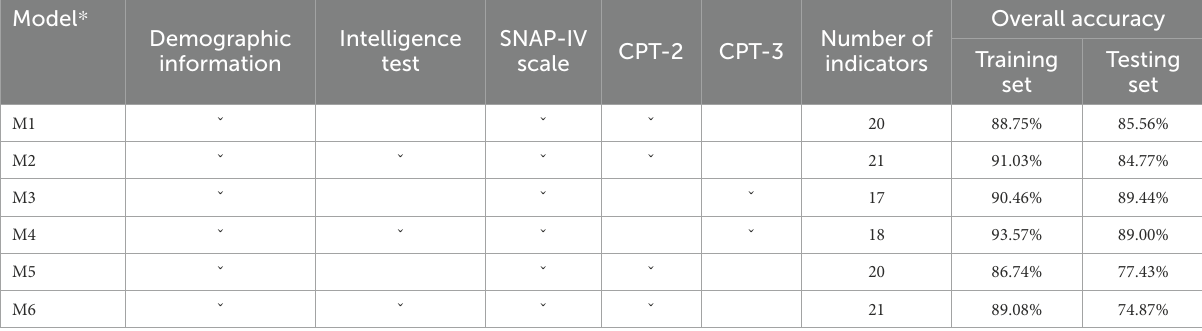
TABLE 3 The overall accuracy of models by using different indicators.